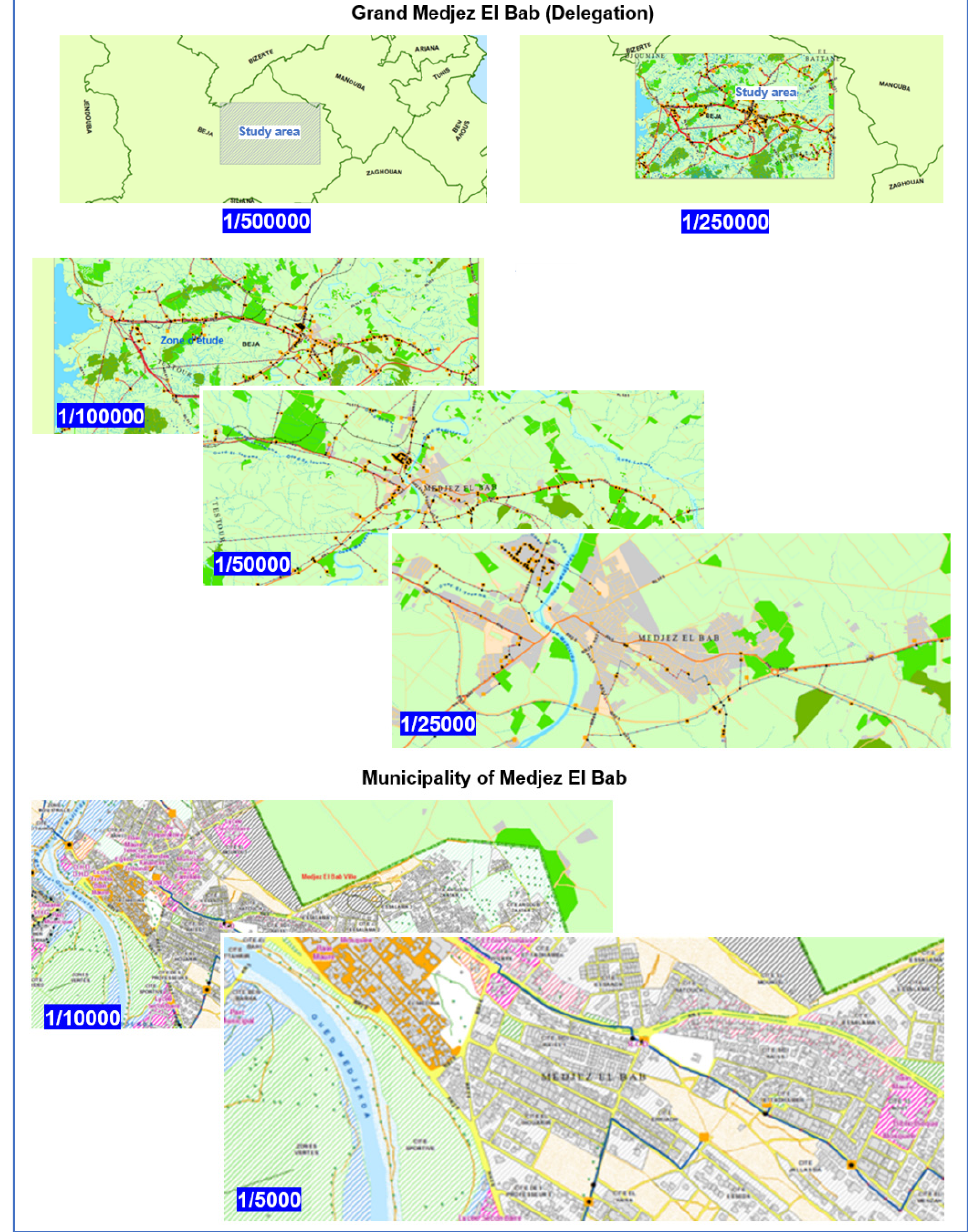
Figure 4. Multi-representation schema of multiple Geodatabases at different scales.